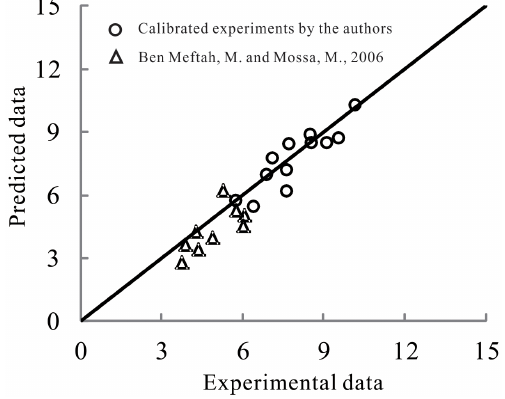
Figure 12. Comparison between predicted and experimental